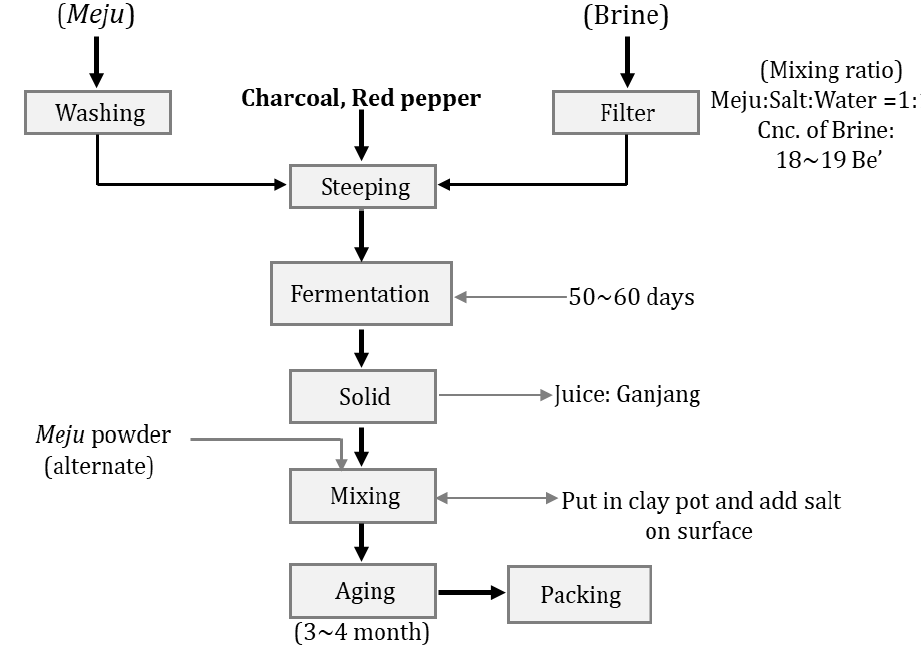
Figure 6. Traditional doenjang preparation.